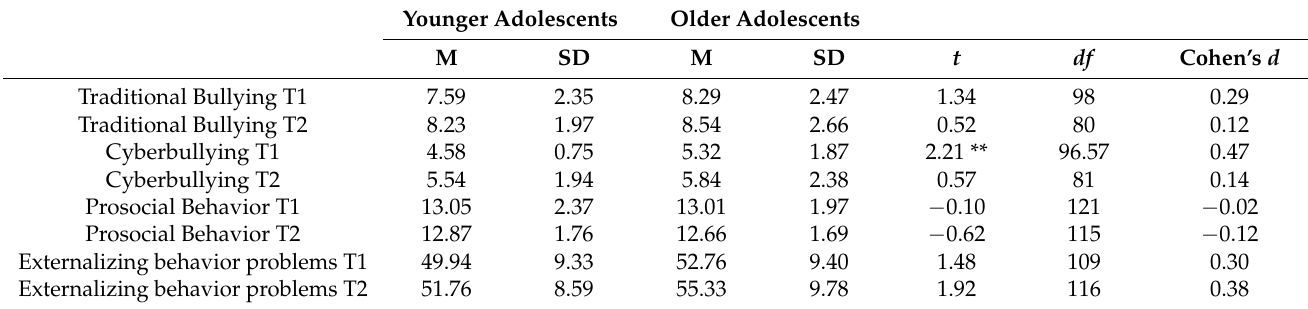
Table 4. t -test for independent samples for age